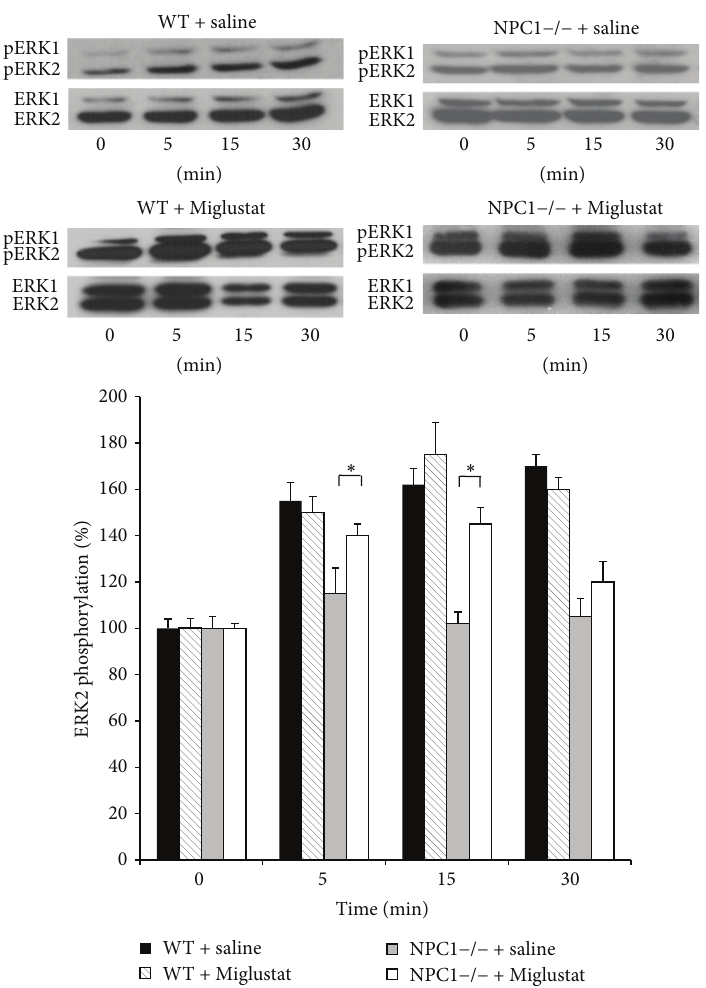
Figure 4: Effects induced by Miglustat treatment on the activation of ERK1/2 during LTP in WT and NPC1 − / − treated mice. The immunoreactive levels of activated and total kinases at the indicate times are shown for a representative experiment in the upper panels; normalized values (means ± SEM) of activated kinases are illustrated in the lower panel ( 𝑛 = 5 for NPC1 − / − mice treated with Miglustat; ∗ 𝑝 < 0.05 versus untreated NPC1 − / − mice at the corresponding time